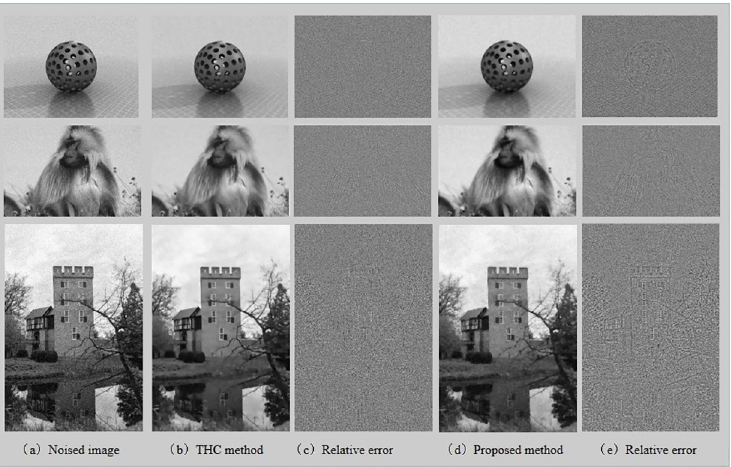
Fig 6. The denoising results for real images, from top to bottom are ‘Ball’, ‘Baboon’, ‘Castle’. (Different from the original picture, it is only for illustrative purposes).